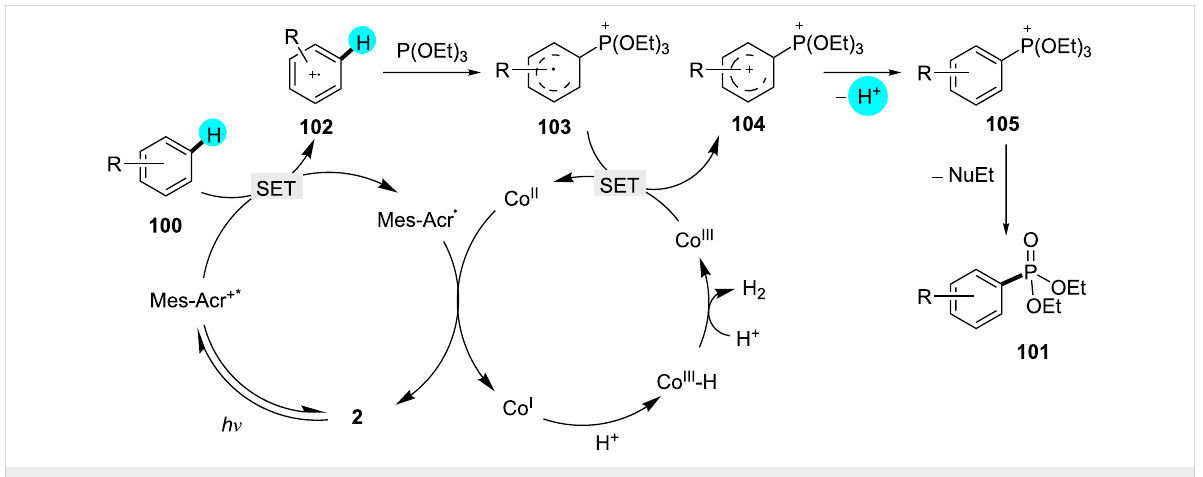
Figure 16: Mechanism proposed for the phosphonylation reaction of 100 .